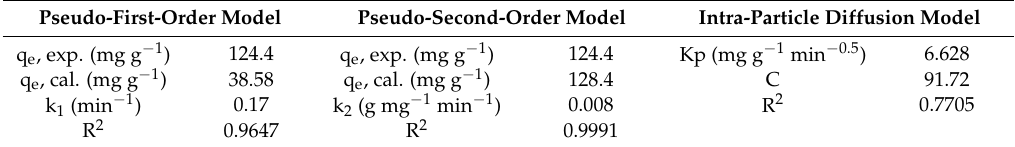
Table 3. Kinetic parameters of Pd(II) adsorption onto the Et- N -Cu(BDC-NH 2 )(DMF) adsorbents. Pseudo-First-Order Model